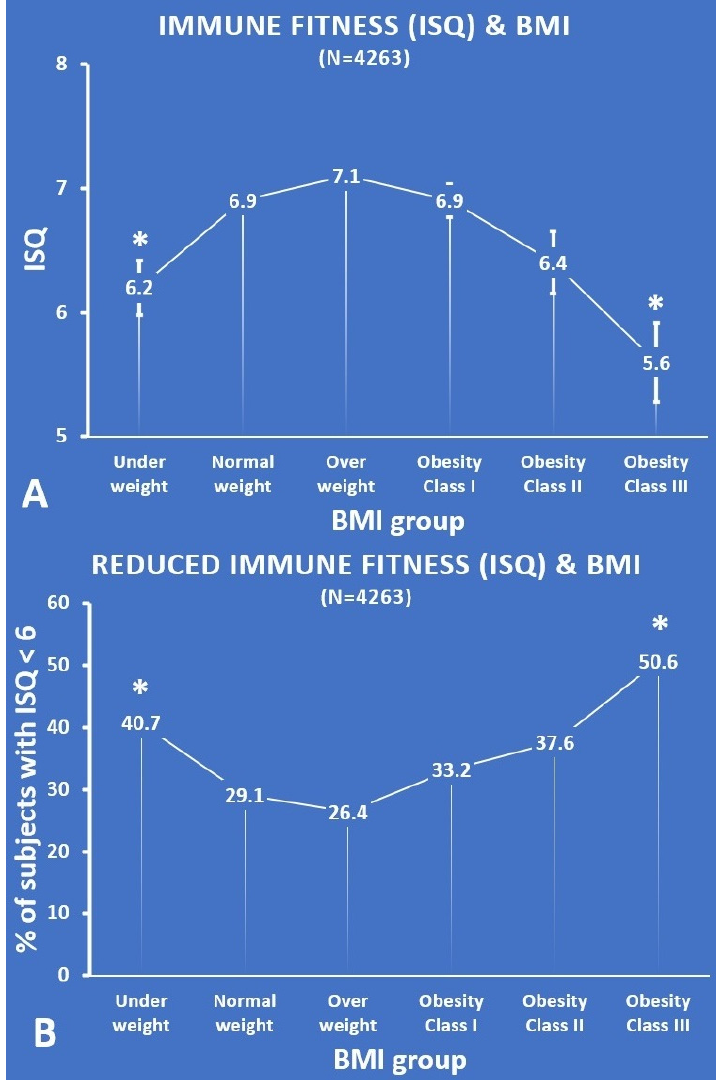
Figure 2. ISQ according to BMI group. ( A ) Each BMI group’s mean (SE) ISQ score; ( B ) the percentage of subjects with an ISQ score < 6. Significant differences ( p < 0.01, after Bonferroni’s correction) compared with the normal weight group are indicated by *. Abbreviations: ISQ = Immune status Questionnaire, BMI = body mass index.